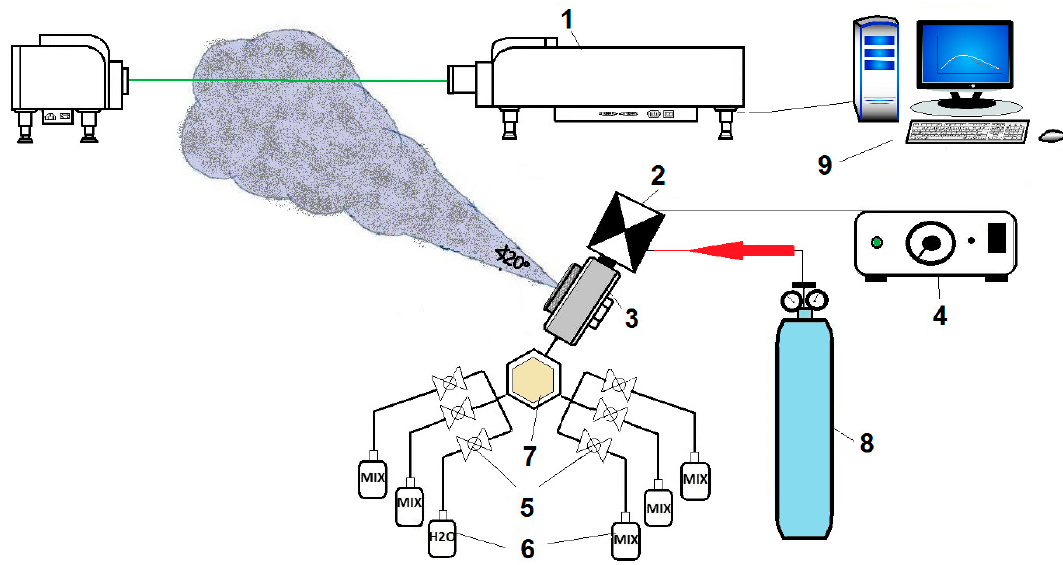
Figure 1. Block diagram of the automated system for the generation of fog with impurities. 1. Laser particle size analyzer, 2. electromagnetic valve, 3. nozzle, 4. spray duration control unit, 5. valves, 6. fluid containers, 7. mixing hub, 8. pressurized gas tank, and 9. PC for processing and visualizing the results.